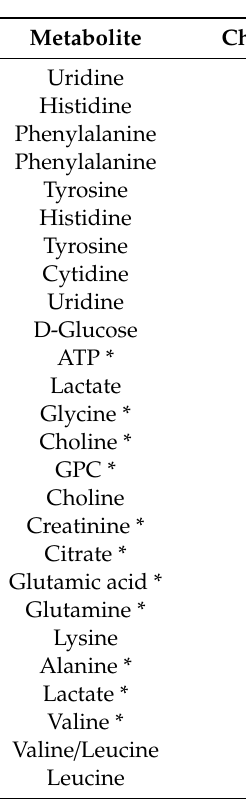
Table 1. 1 H NMR spectrum assignments of pig seminal plasma metabolites. Metabolites used in the statistical analysis are indicated by an asterisk